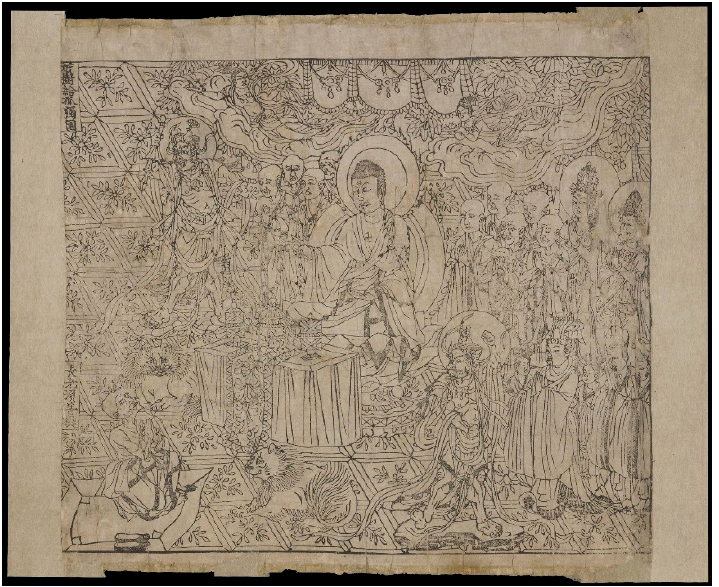
Figure 7. Frontispiece to the Diamond S ū tra . Found in Cave 17 of Mogao Grottoes, Dunhuang, China. 868 CE, Tang (618–907). Xylograph; ink on paper. H. 27.6; W: 28.5 cm. British Library.